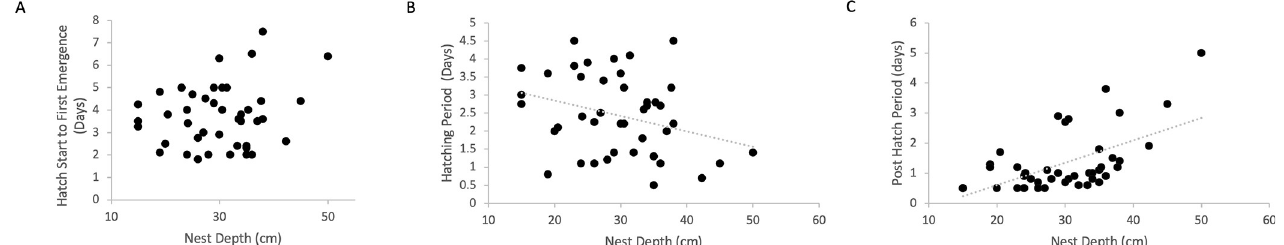
Fig 7. The impact of nest depth on phase duration. Deeper nests are correlated with a longer post-hatch phase in Caretta caretta hatchlings (n = 43 nests from 2015–17 nesting seasons). A) The time between the start of hatching and the first turtle emergence is not increased in deeper nests ( r (41) = .1814, p = .24). B) There is a weak negative correlation between depth of the nest and hatching period duration ( r (41) = -.3075, p = .0449). C) There is a strong positive correlation between nest depth and time to emergence, where deeper nests have a significantly longer posthatch phase ( r (41) = .5805, p =